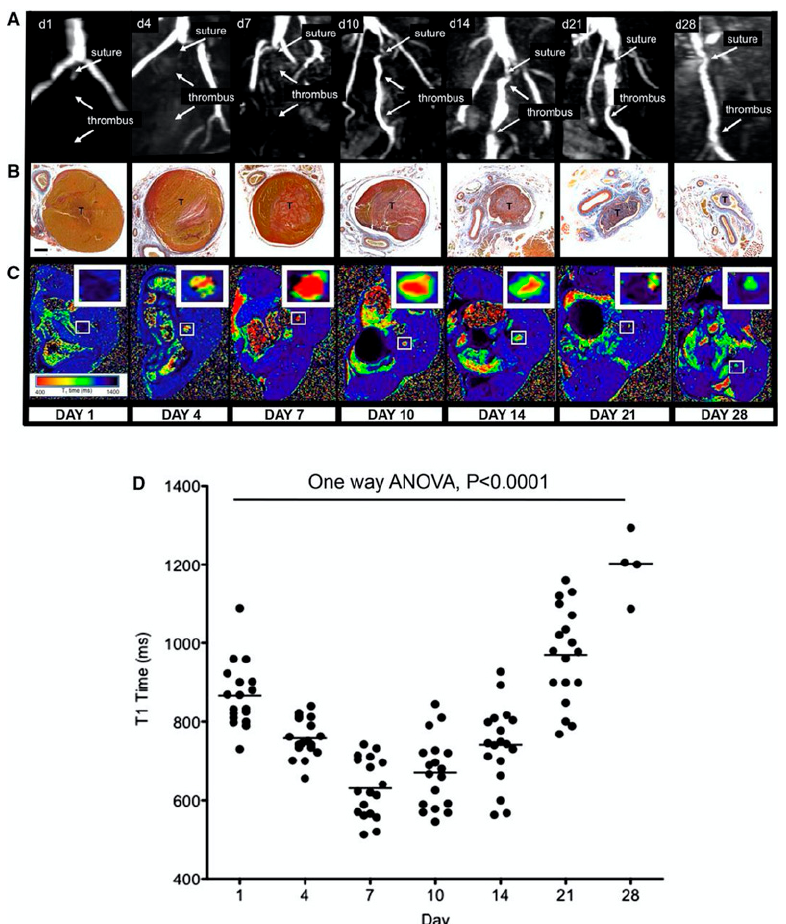
Figure 18. Magnetic resonance T1 mapping of experimental venous thrombi. ( A ), MRI venography demonstrates the presence of thrombus in the murine inferior vena cava, which recanalizes over 28 days. ( B ), MSB sections of venous thrombus (T) during its resolution (yellow = red cells, red = fibrin, blue = collagen; × 200; bar, 200 µ m). ( C ),CorrespondingT1mapsweregeneratedbytheuseofacustomised program (MATLAB software, MathWorks) before importation into OSIRIX as shown. Short T1relaxation times (ms) appear red and revert back to blood (black) as thrombus ages. ( D ), Mean T1 relaxation times (ms) of the thrombus change during its resolution (scatter plot and mean of thrombus T1 relaxation time [ms] is shown, n = 88 mice, p < 0.0001, 1-way ANOVA). Mouse procedures were performed under the Animals (Scientific Procedures) Act, 1986, UK. ANOVA indicates analysis of variance; d—day; and MSB— Martius Scarlet Blue. Reproduced with permission from Saha et al., 2013